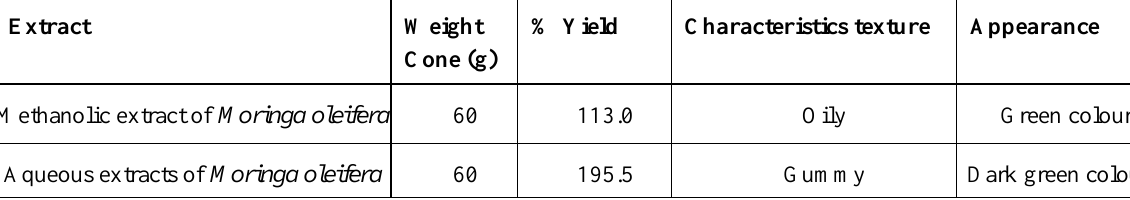
Table 1. The physical characteristics of both methanolic and aqueous extract of Moringa oleifera . Extract